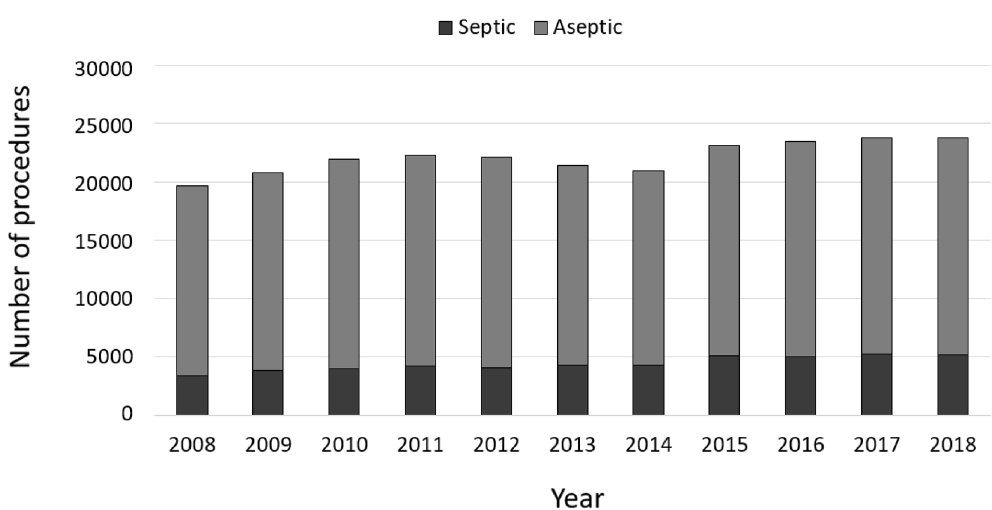
Figure 5. Performed revision knee arthroplasty procedures from 2008 through 2018 divided in septic and aseptic